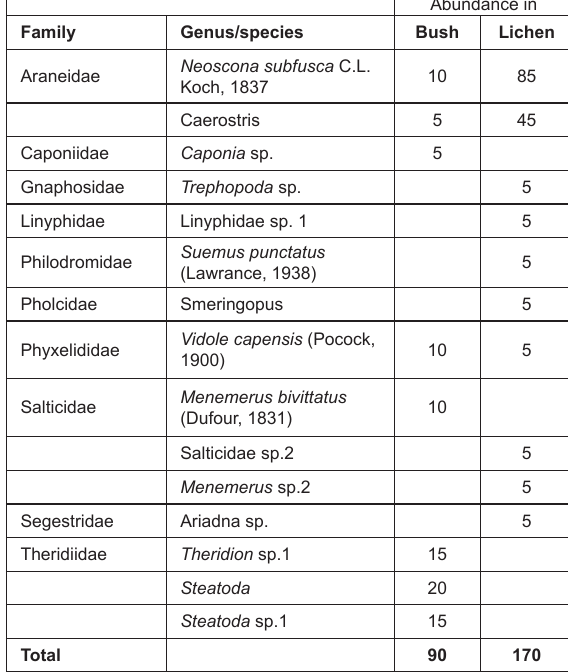
Table 1. Comparative abundance of spiders in two microhabitat of Robben